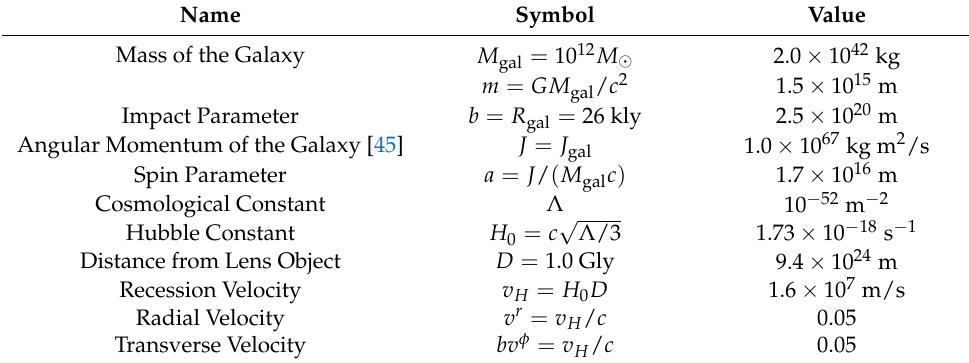
Table 1. Numerical values. We use the following numerical values in this paper. As the value of the total angular momentum J gal , we adopt that of our Galaxy J gal (cid:39) 1.0 × 10 67 kg m 2 /s from